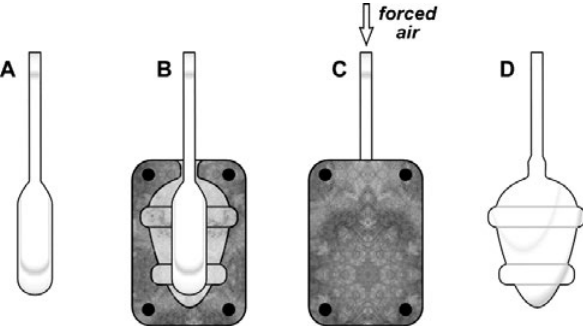
Figure 8. Blow-molding with a two-piece mold: : (A) hollow glass blank; (B) glass blank inserted into mold; (C) mold fastened togeth- er and softened glass blown to fill mold; (D) mold disassembled and hollow vessel isolated [reprinted with permission from refer- ence 2. Copyright 2015, American Chemical